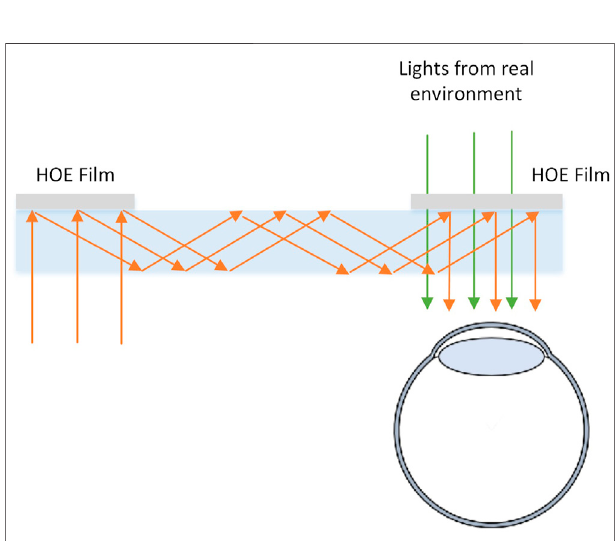
FIGURE5| SchematicdiagramofwaveguidebasedARNEDusingHOE as the in- and out-couplers (Only the central FOV of the NED system is shown in the